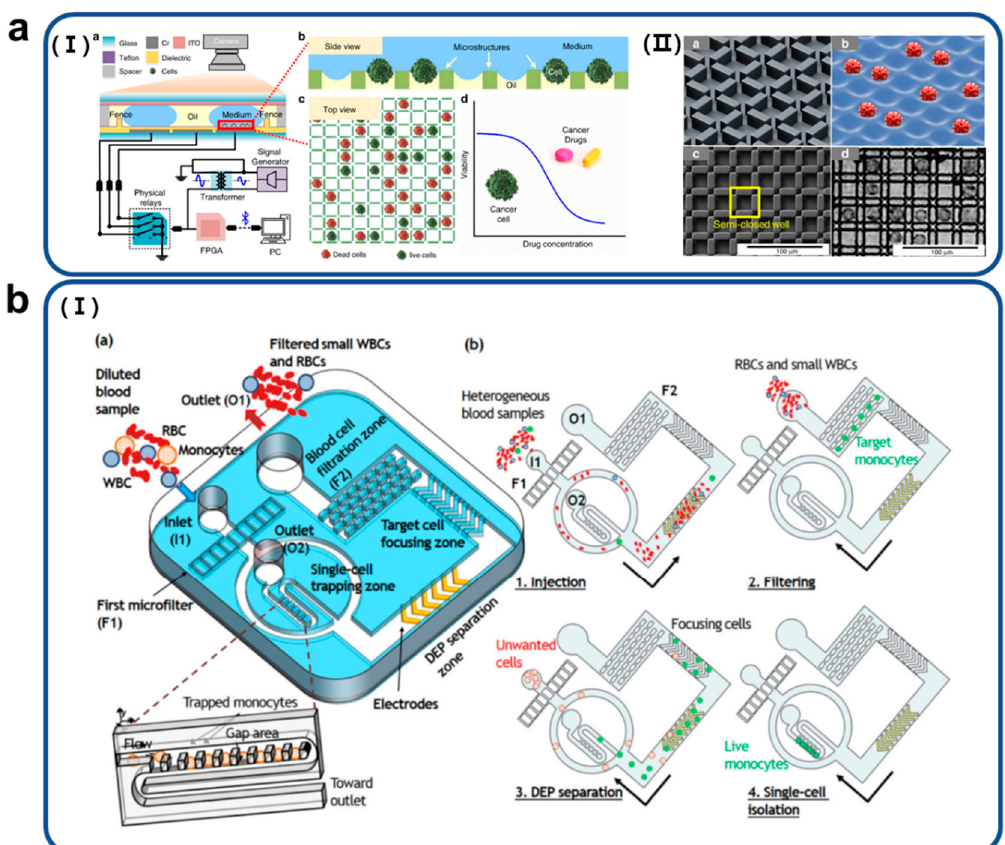
Figure 3. ( a ) (I) Schematic images (side view) of developed digital microfluidic device and (II) 3D microstructures to isolate single cells and investigate the cell response for drug sensitivity test. Reproduced with permission from [48]. Copyright Microsystems & Nanoengineering 2020. ( b ) (I) The integrated microfluidic platform enabling size-selective single-cell isolation, composed of hydrodynamic microfiltration, dielectrophoretic separation, and a microwell array. Reproduced with permission from [49]. Copyright Biomicrofluidics 2021.